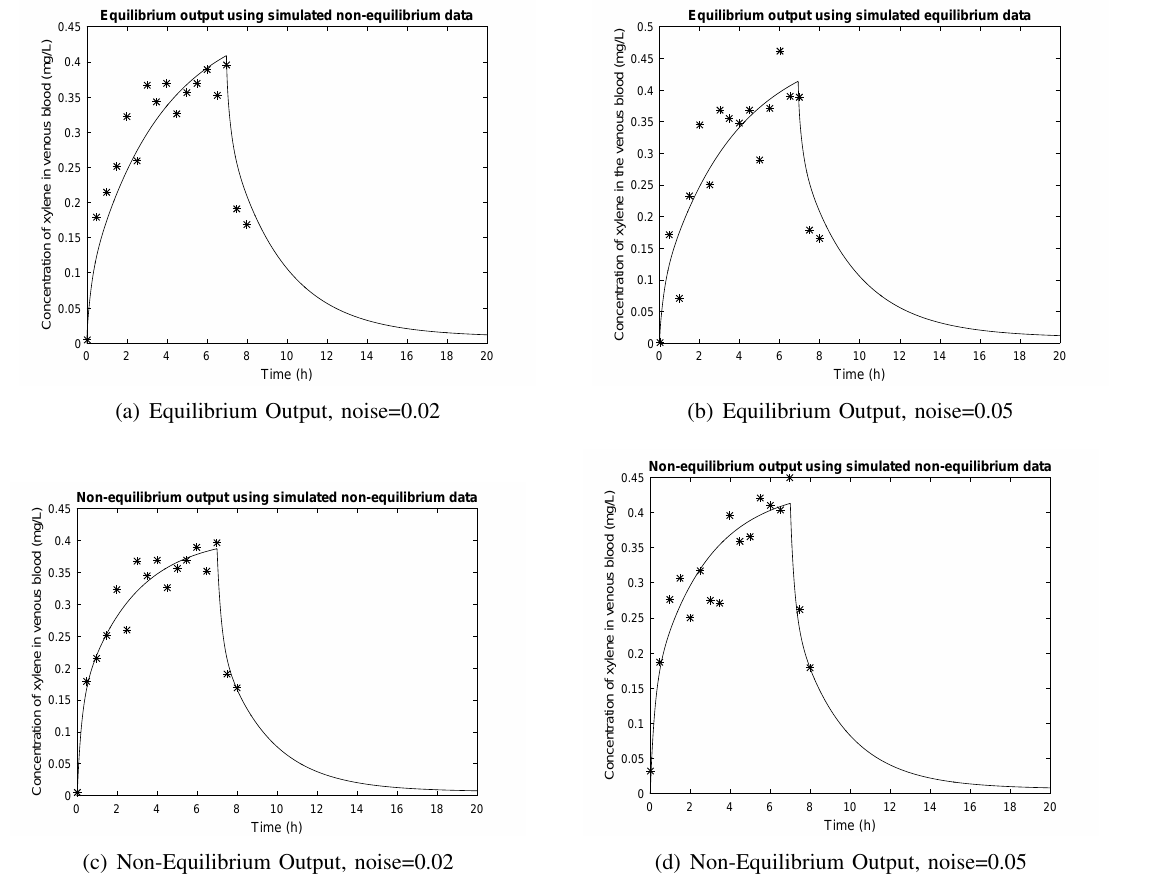
of 0.0058. The best fit for the non-equilibrium model is produced with a V xyl maxc value of 1.8514, yielding a cost of 0.0203. The fits of the equilibrium and non-equilibrium models to non-equilibrium data are presented in Figure 9. Figures 9(a) and 9(b) display the fit of the equilibrium model to non-equilibrium data with noise levels of 2% and 5%, respectively. Results for the non-equilibrium model fitted to the non- equilibrium data with noise levels of 2% and 5% are depicted in Figures 9(c) and 9(d). A visual inspection of the graphs would suggest that both the equilibrium model and the non-equilibrium model can provide an adequate fit to the